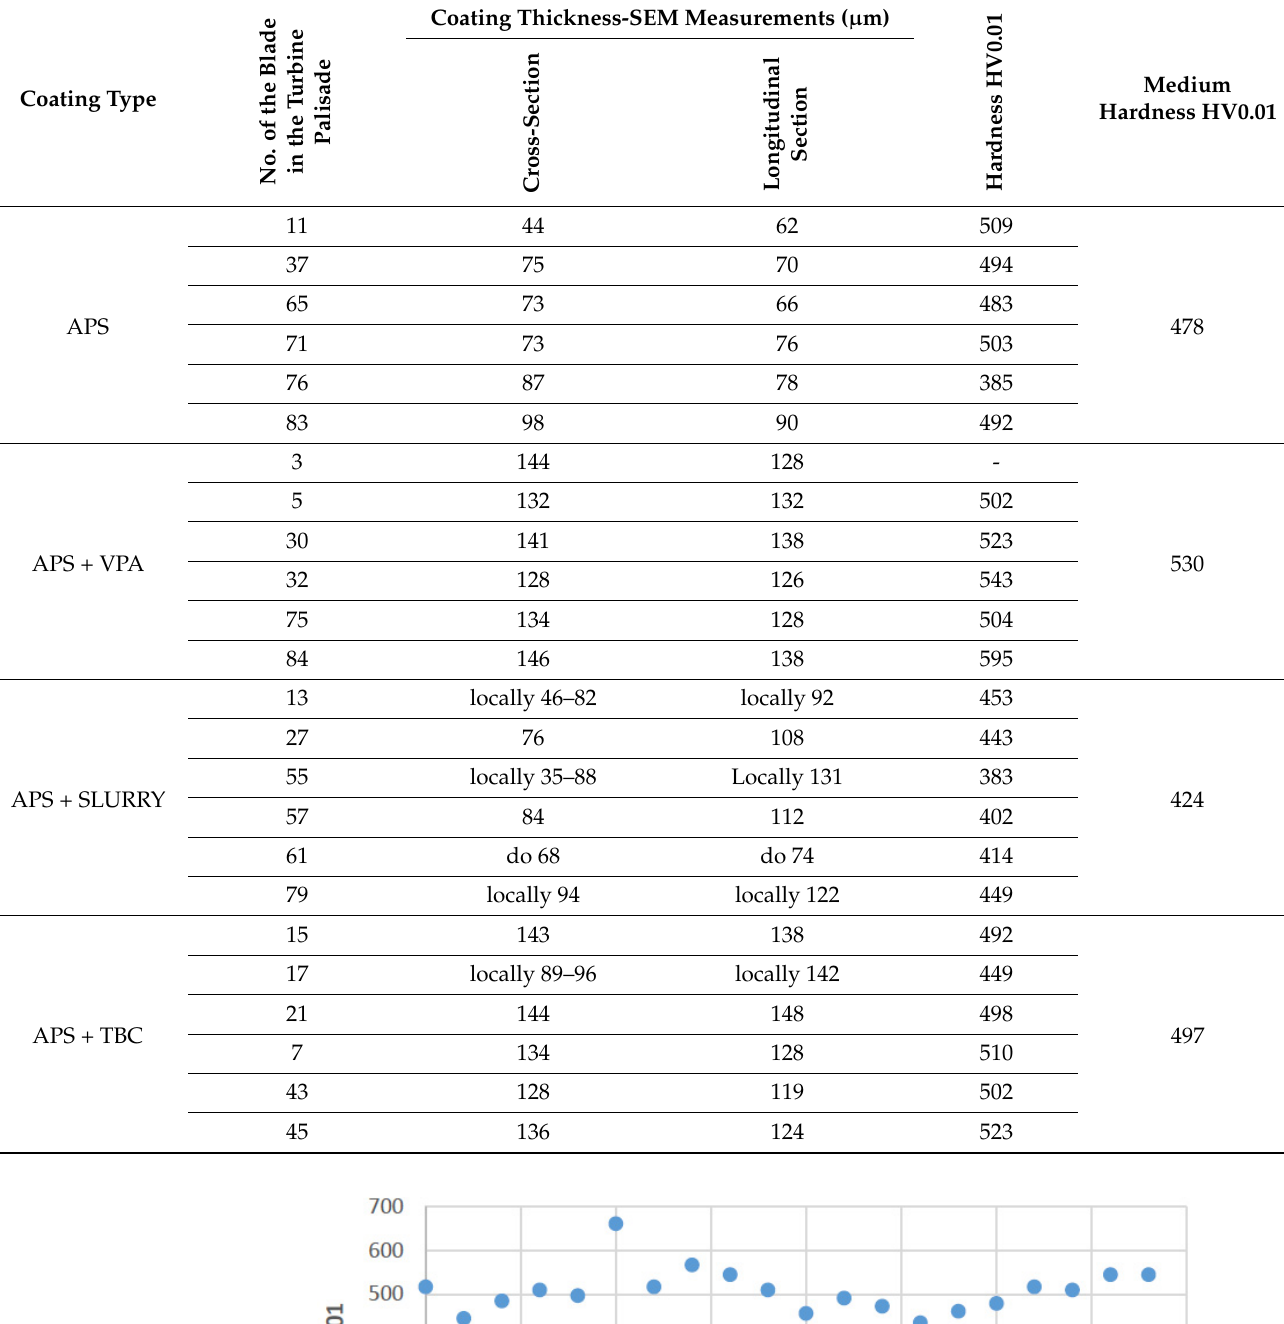
Table 3. The results of measurements of the thickness of protective coatings and their hardness HV0.01 in the leading edge zone.